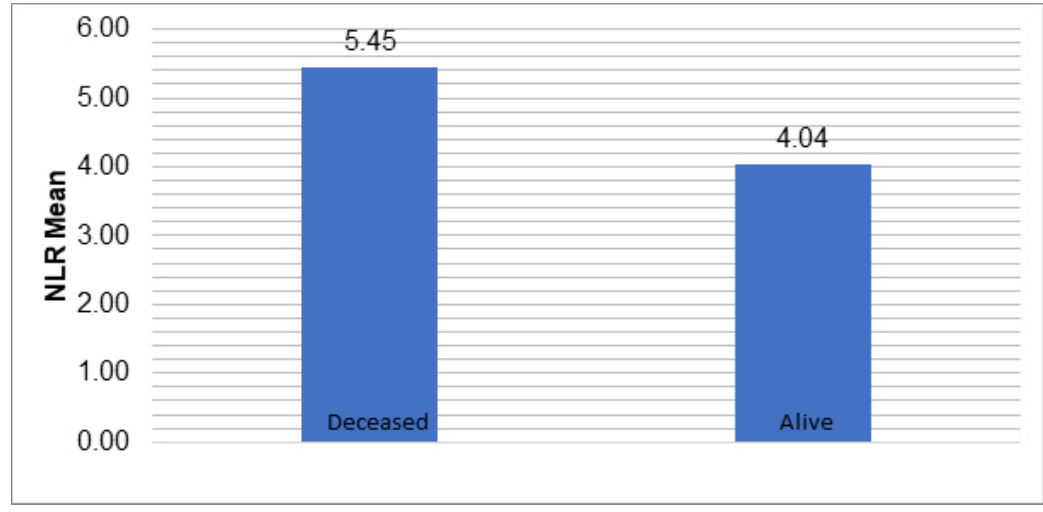
Fig. 1. Mean NLR ratio for deceased and survivors during the data collection